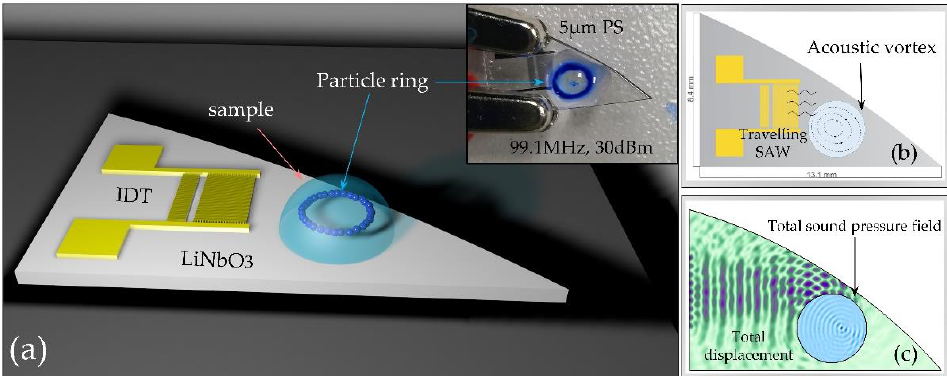
Figure 1. ( a ) Schematic diagram of the acoustofluidic device: Curved-edge cut lithium niobate substrate and sample droplets placed on the surface. The inset depicts the particle ring shape was exhibited under acoustic vortex capture with 5 µ m particles. ( b ) Design diagram of the device. Acoustic vortex induced by asymmetric propagation of Travelling SAW excited by the interdigitated transducer (IDT) in a sample droplet. ( c ) Numerical simulation of the propagation and radiation of TSAWs in water.